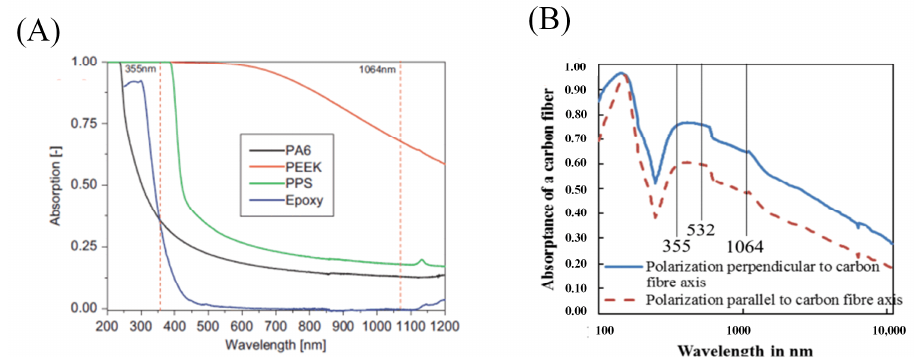
Figure 9. Absorption rates of different wavelengths of light by carbon fiber and epoxy resin respec- tively: ( A ) absorption spectra of resin materials [50]; ( B ) the average absorption curves of single carbon fiber for different laser wavelengths [51].